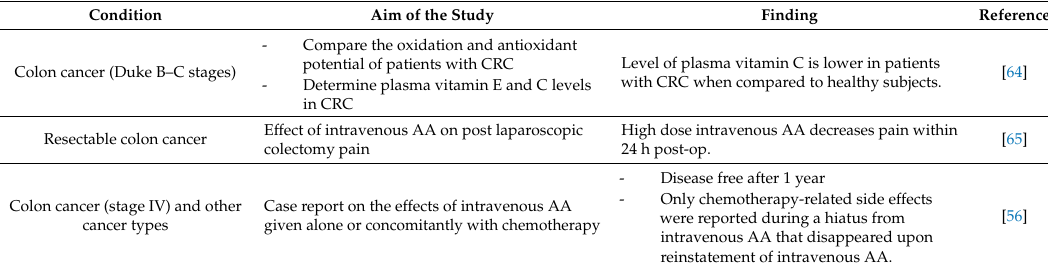
Table 2. Clinical studies of AA in colorectal